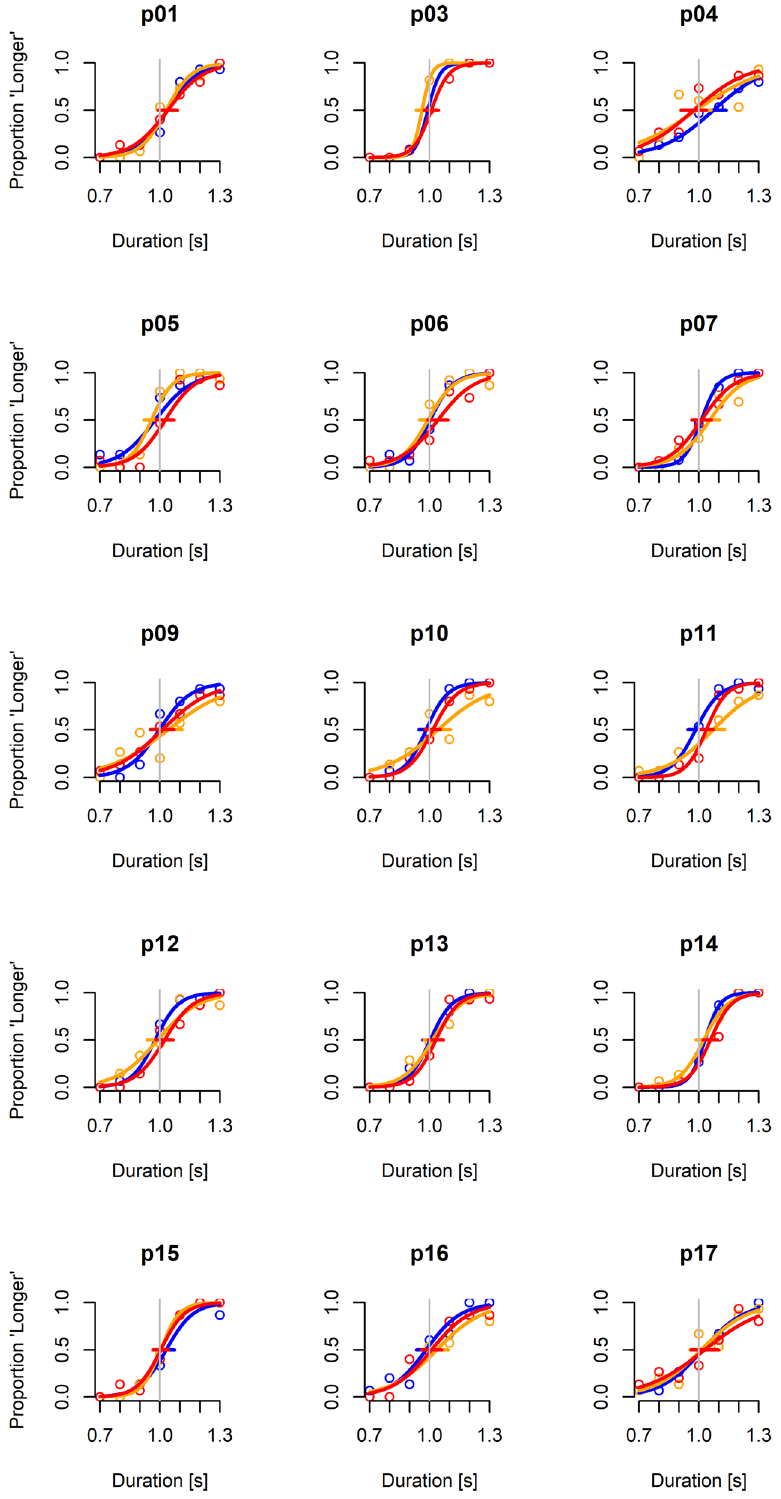
Figure 4. Psychometric functions for all participants (except the outliers) and laws of motion. Blue, orange and red curves correspond to constant tangential velocity, constant vertical velocity, and gravitational acceleration, respectively. Gray vertical line represents the reference duration (1